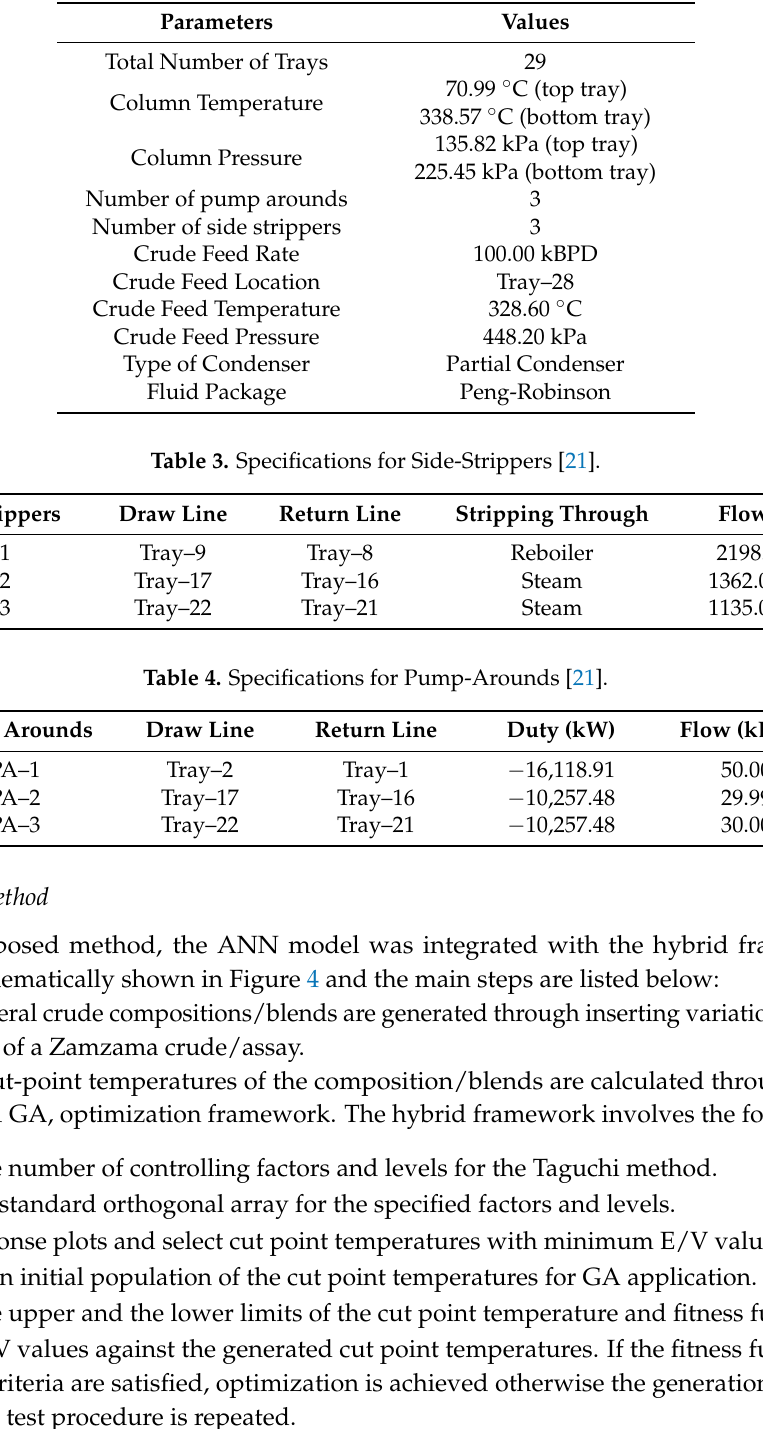
Table 2. Parameters for Designing the CDU [21].